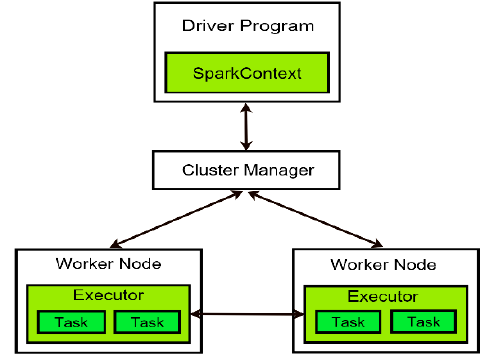
Figure 2. Spark Architecture in Cluster Mode.